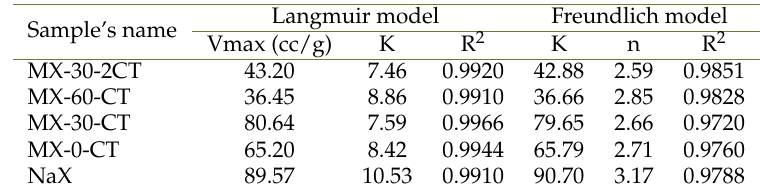
Table 1. Isotherm model parameters of CO 2 adsorption on zeolite and mesoporous zeolites